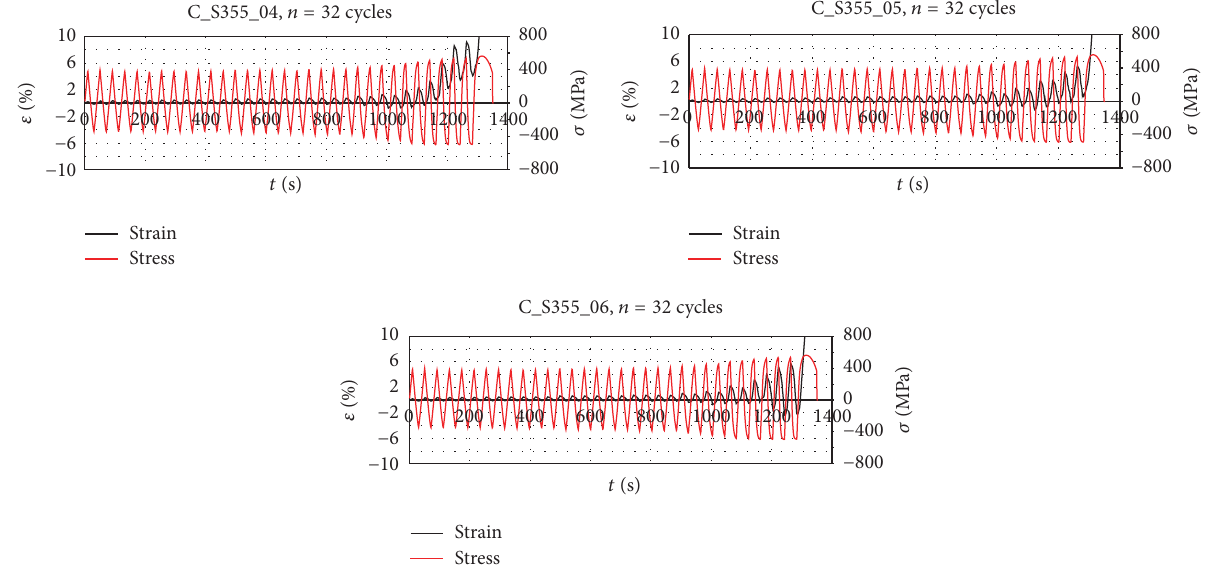
Figure 5: Strain and stress records for 15 specimens of steel grades S275 and